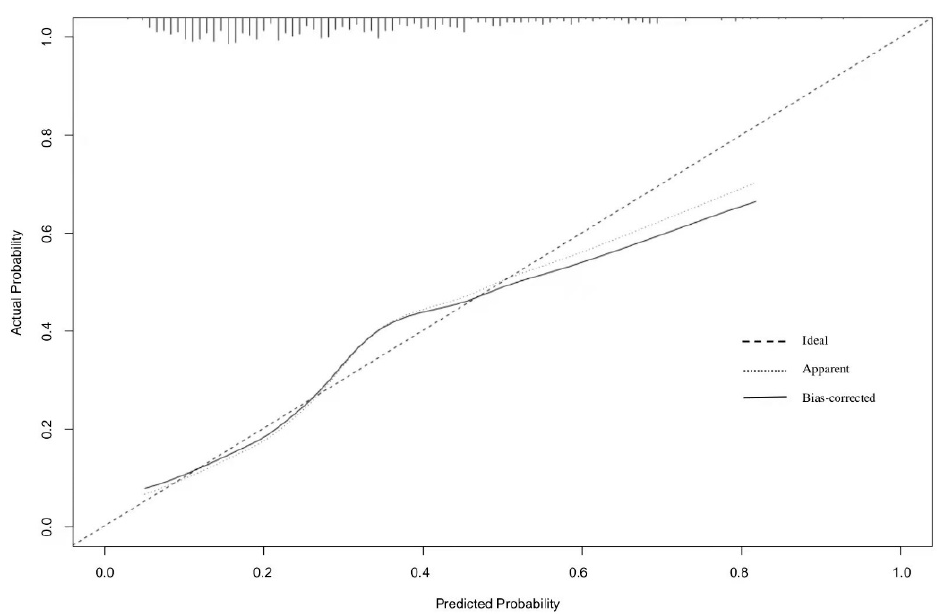
Figure 3. Calibration curve of the nomogram for predicting AKI.